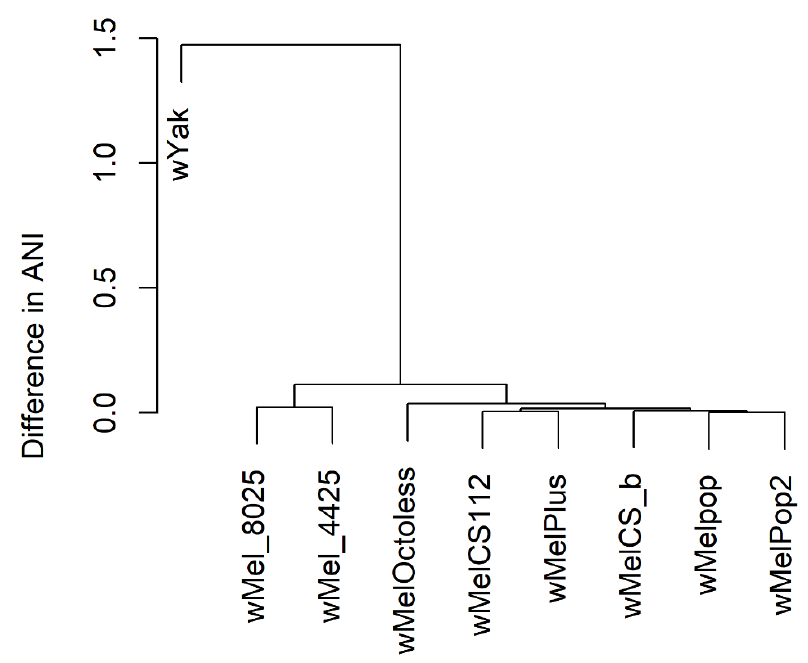
Figure 2. The dendrogram reflecting genome similarity between the analyzed strains based on average nucleotide-identity (ANI) values. wMel_8025 and wMel_4425 correspond to the wMel strain genome assemblies GCF_000008025.1 and GCF_016584425.1, respectively.